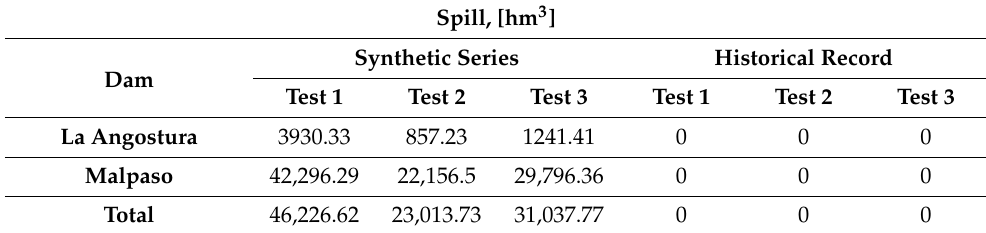
Table 9. Comparison of total spillage: 10 synthetic series vs. historical record.